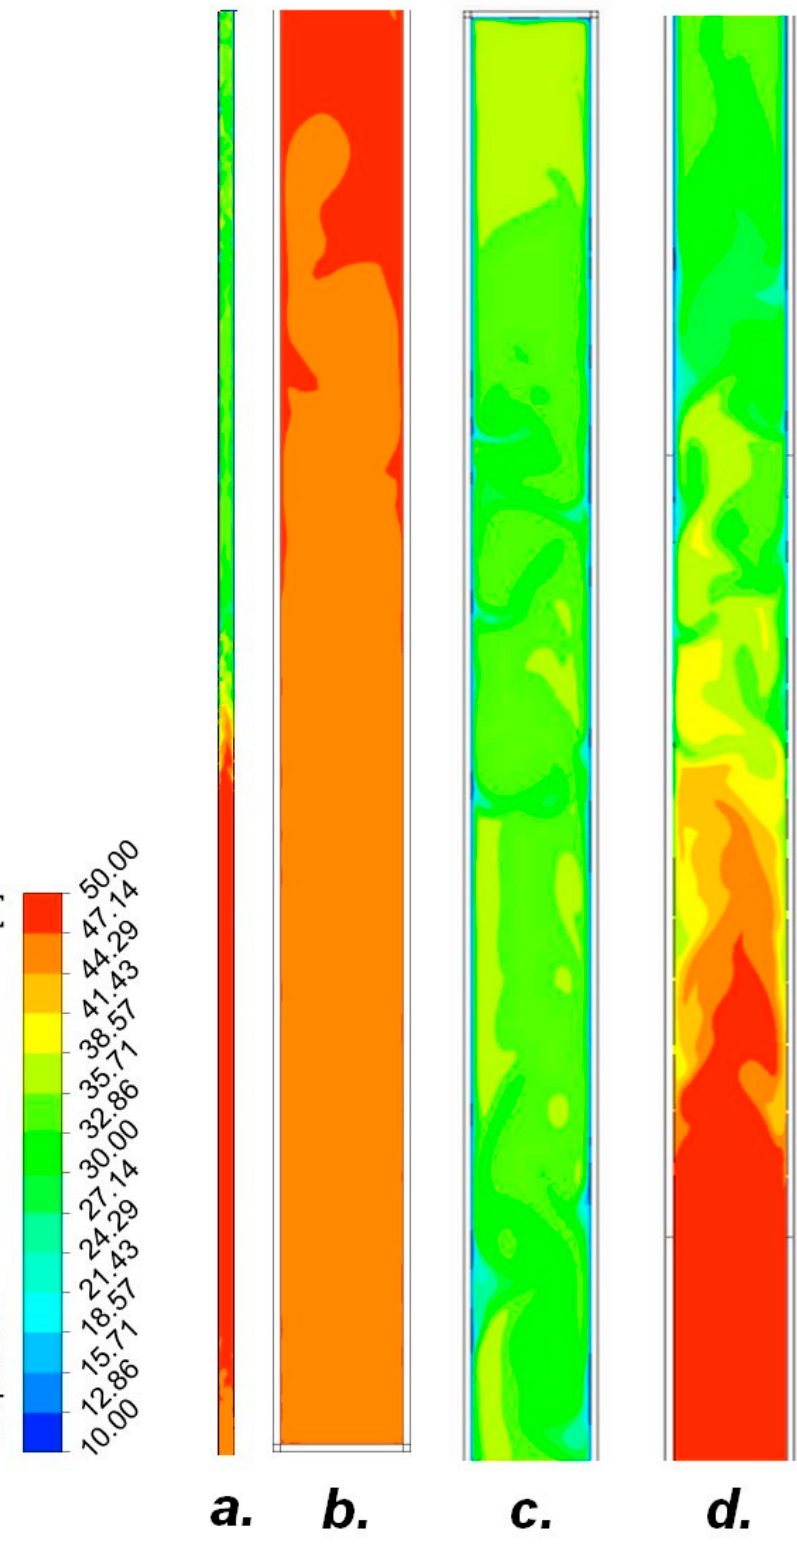
Figure 7. Temperature distribution in the heat pipe. ( a ) Total heat pipe; ( b ) evaporator section; ( c ) condenser section; ( d ) isothermal section.